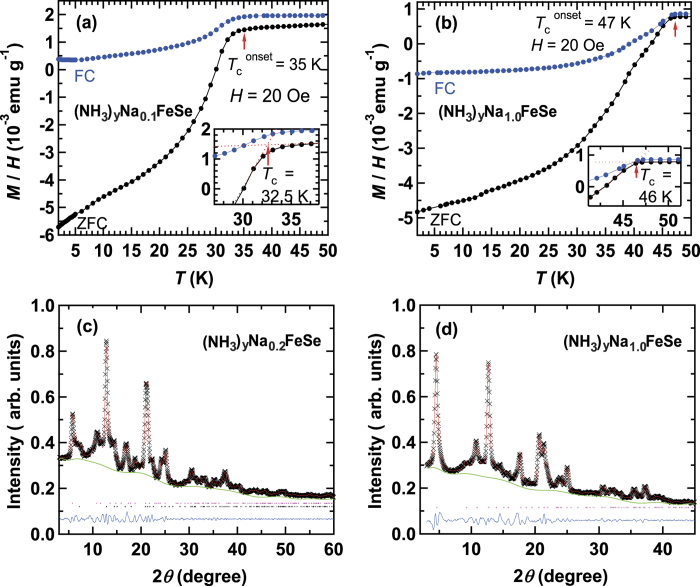

M / H vs. T plots of (a) (NH3)yNa0.1FeSe (low-Tc phase) and(b) (NH3)yNa1.0FeSe (high-Tc phase) in ZFC and FC modes (H = 20 Oe). Insets in (a) and (b) show the method used to determine Tc. XRD patterns of (c) (NH3)yNa0.2FeSe (low-Tc phase) and (d) (NH3)yNa1.0FeSe (high-Tc phase); ‘x’ marks correspond to the experimental XRD patterns. Red and green lines refer to calculated patterns (LeBail fitting) and background, respectively. Ticks refer to the peak positions predicted. In (c), two phases ((NH3)yNa0.2FeSe and β-FeSe) are used in LeBail fitting, while in (d), a single phase ((NH3)yNa1.0FeSe) is used.